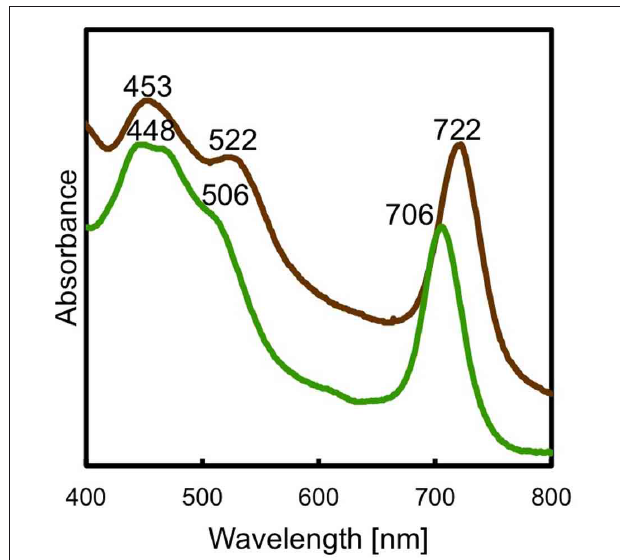
FIGURE 4 | Whole-cell absorption spectra of C. limnaeum 1677 T WT (brown line) and the bchU mutant (green line).